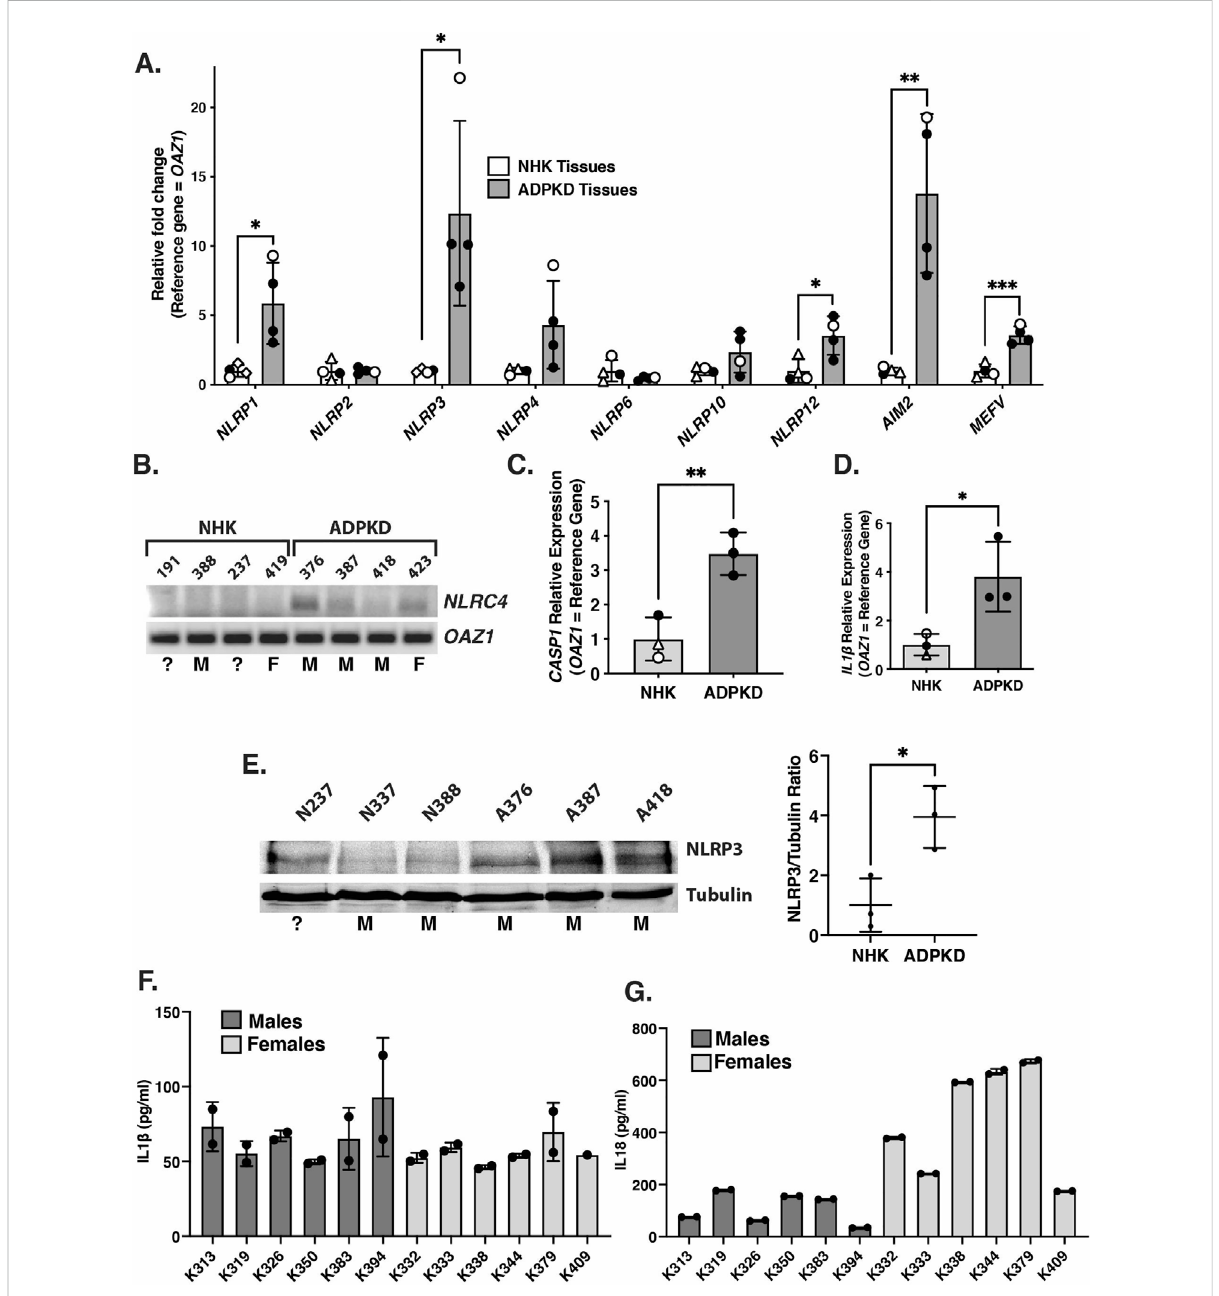
Expression of in fl ammasome sensors and components are elevated in kidneys from ADPKD patients. (A) qRT-PCR of transcripts encoding in fl ammasome sensors from kidneys of patients with ADPKD or from non-cystic human kidneys (NHK). Open circles = females; closed circles = males; open triangles = unknown sex. (B) Semi-quantitative PCR products of NLRC4 and reference gene ( OAZ1 ) from cDNAs of transcripts from the same kidney samples as in (A) . Assigned kidney numbers are shown for each NHK and ADPKD sample. M = male; F = female; ? = unknown sex. (C,D) qRT-PCR of transcripts CASP1 (C) and IL1 β (D) from ADPKD and NHK kidney tissues samples. Symbols indicating sex are the same as in (A) . (E) Western blot of NLRP3 and tubulin from NHK and ADPKD kidney protein samples. Assigned kidney numbers and sex are shown. On right is graph showingtherelativeNLRP3/Tubulinproteinlevelsmeasuredfromtheblot. (F,G) ConcentrationsofIL-1 β (F) andIL-18 (G) induplicatesamplesofcyst fl uids collected from individual male and female patients with ADPKD measured by